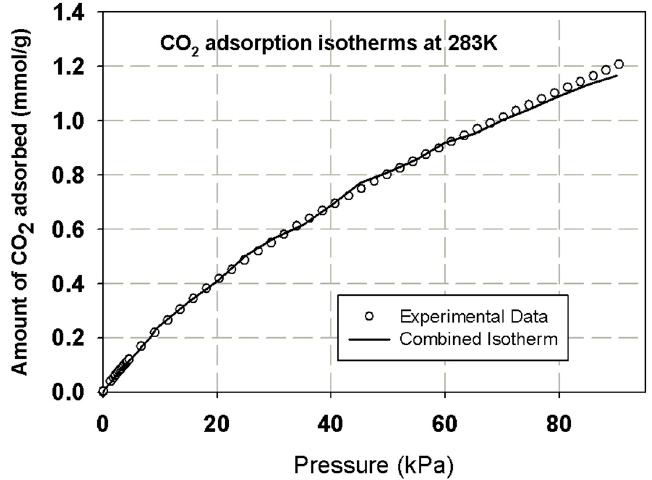
Figure 16. Comparison of experimental and simulated isotherms for CO 2 adsorption by porous silica glass ( sample SG2 - 200 ) at 283 K.